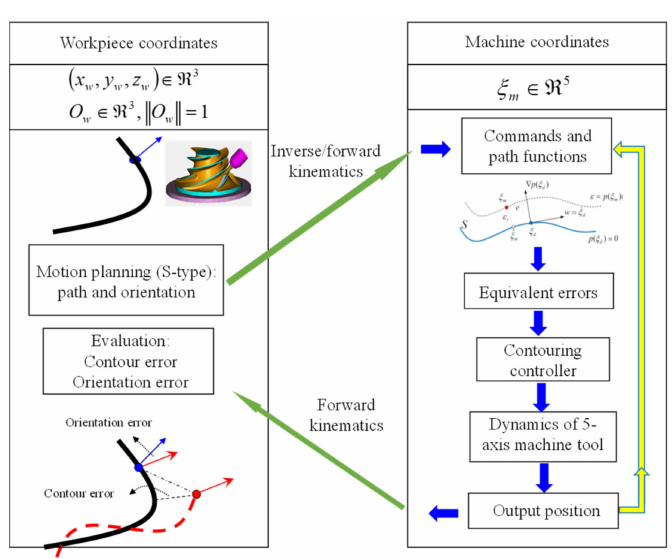
Figure 5. Configuration of the method of equivalent